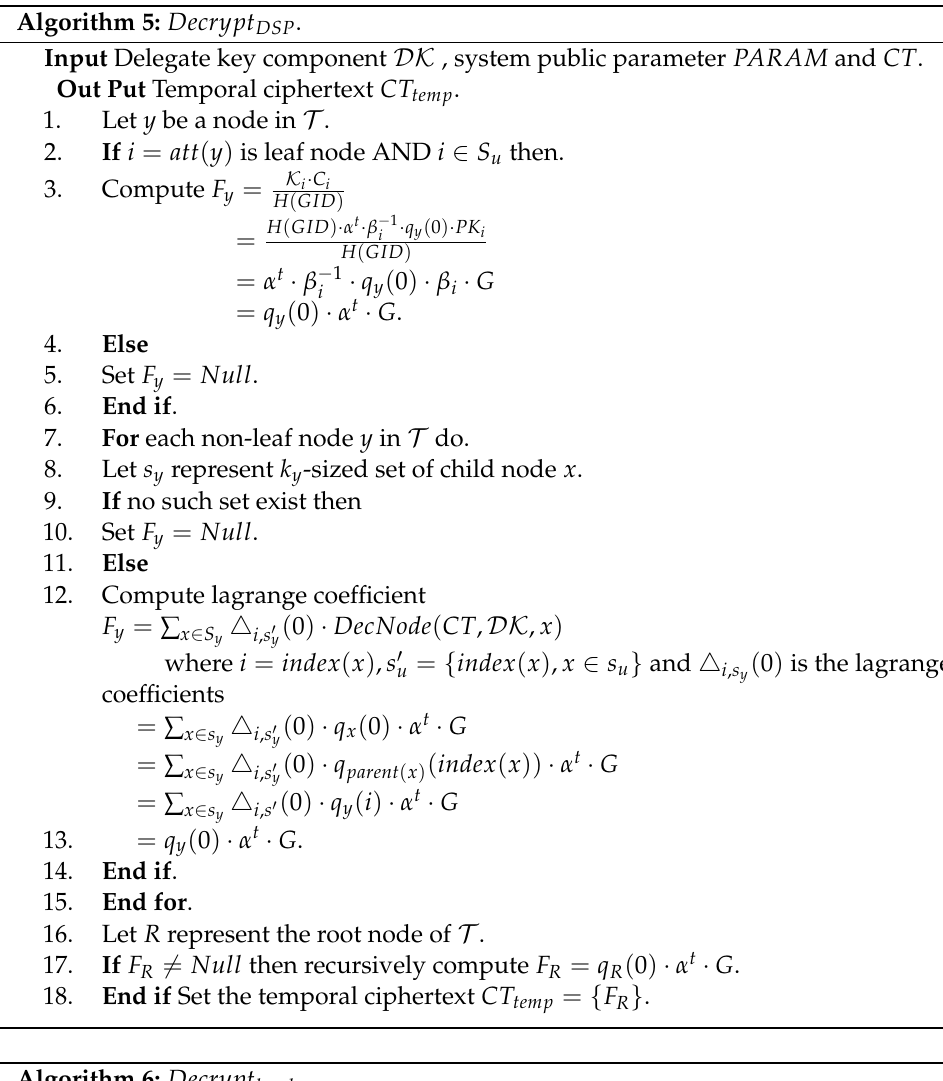
Algorithm 5: Decrypt DSP .